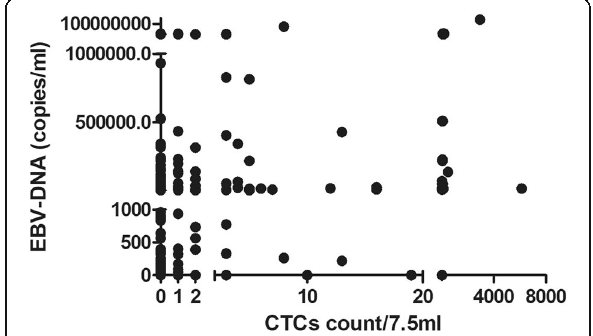
Fig. 4 Scatterplot of EBV-DNA associated with